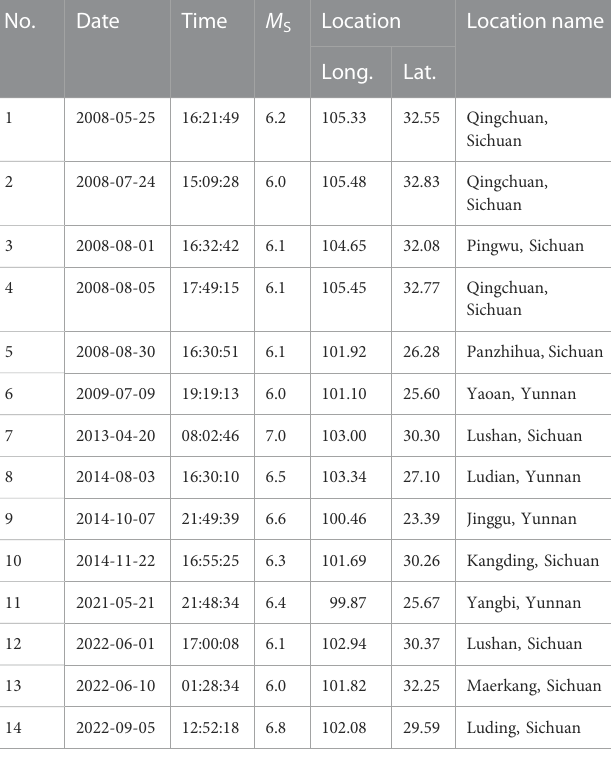
TABLE 1 Target earthquakes ( M S > 6.0) in the test area in the Sichuan-Yunnan region,China,duringthethreeperiodsofMay20,2008 – May20,2011,January1, 2013 – January 1, 2016, and September 10, 2019 – September 10, 2022. No.